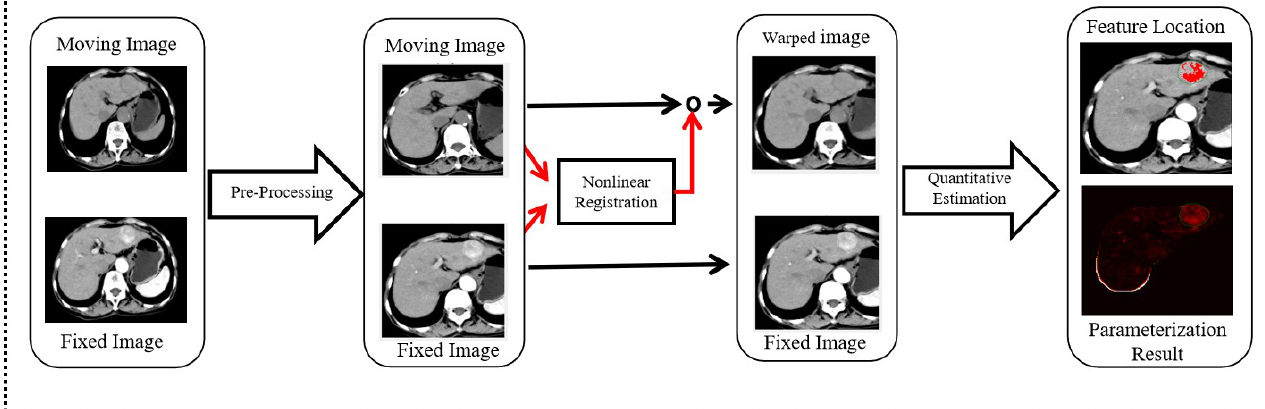
Figure 3. Illustration of 3D quantitative estimation model. Circle denotes a composition where the warped image is reconstructed by the deformation field computed from nonlinear registration, resulting in the warped